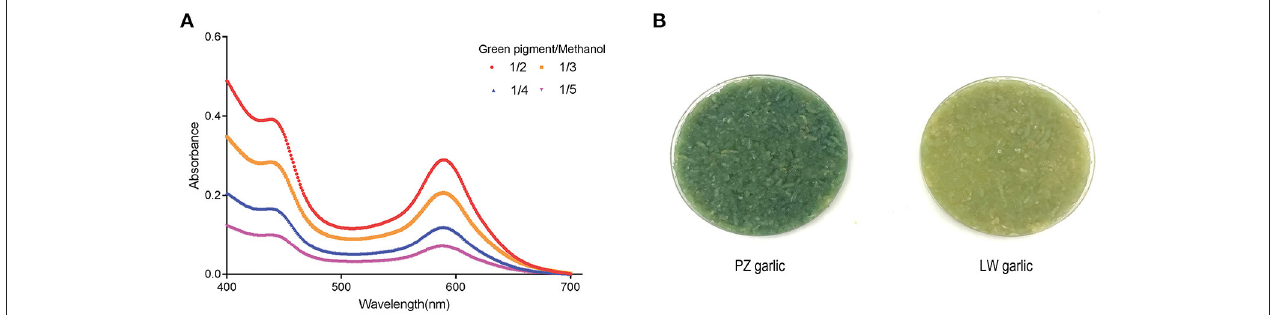
FIGURE 1 | Extraction of garlic green pigment. (A) Measuring absorption spectrum of garlic green pigment. Mixed samples of Pizhou (PZ) garlic and Laiwu (LW) garlic were used for green pigment measurement. 440nm indicated yellow pigment crests and 590nm indicated blue pigment crests. (B) Green color change of PZ garlic and LW garlic. PZ garlic on the left and LW garlic on the right.